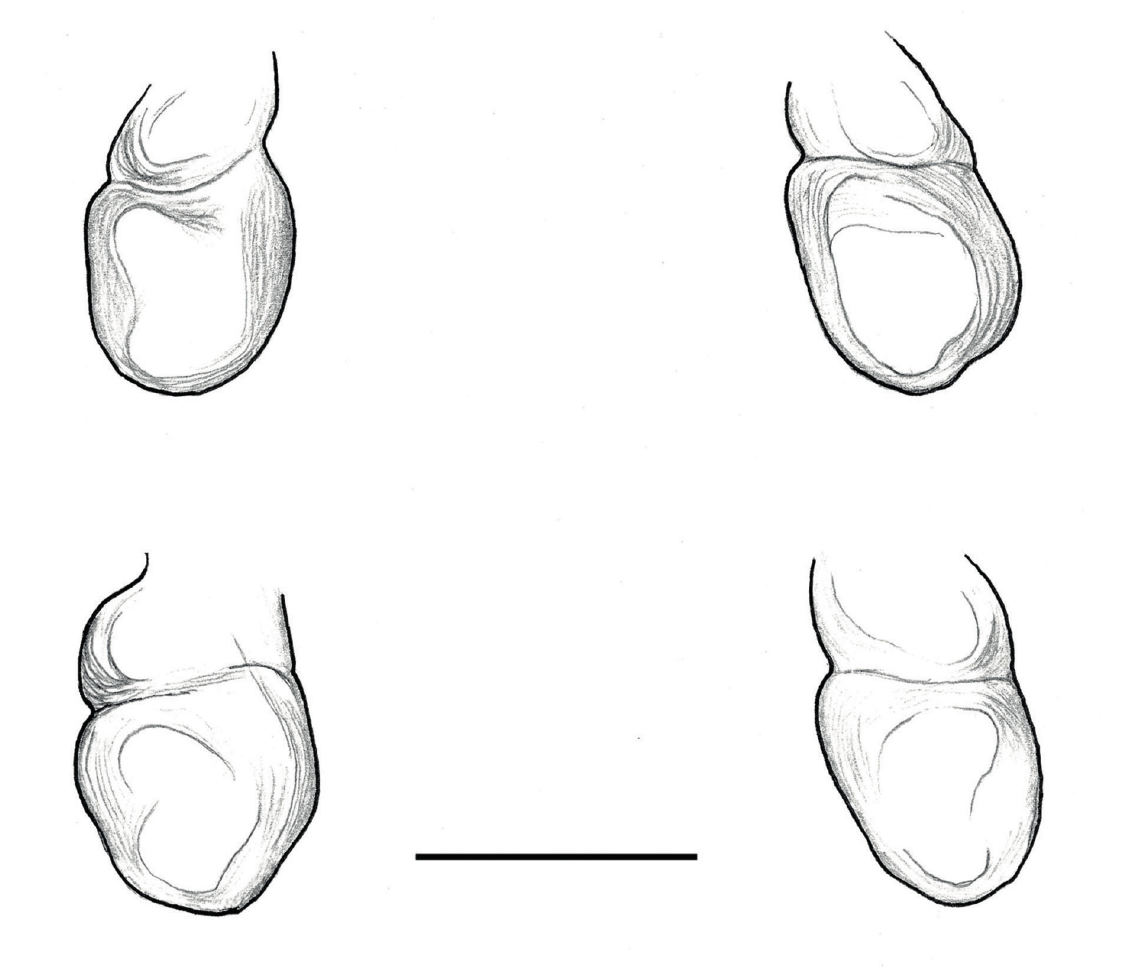
Fig. 7. Female Leiolima iberica gen. et sp. nov.; seminal receptacles, distance between left and right receptacles to scale. Paratypes: top: ZUPV 3333 at CHW, bottom ZUPV 4108 at CHW. Scale bar: 50